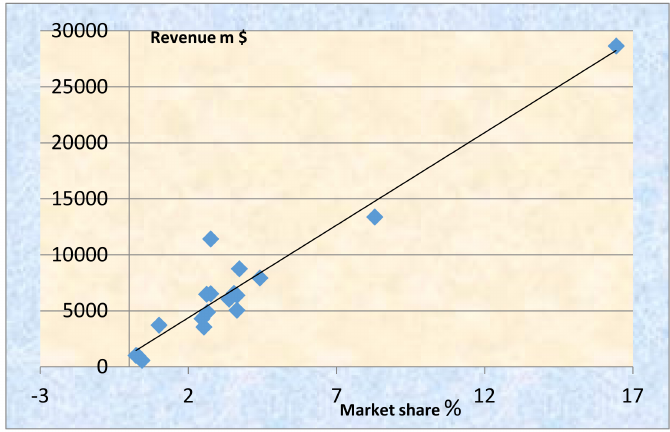
Figure 10. Regression between revenue and market share (2008; 2010). Source: Author and excel on numbers from Sys et al.